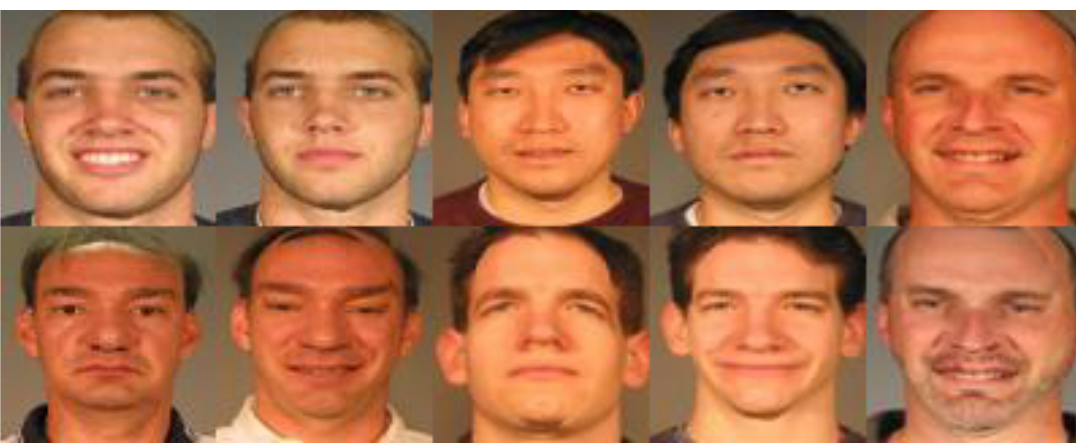
Figure 2. Some 2D face images rendered from input face images using a 3D morphable model